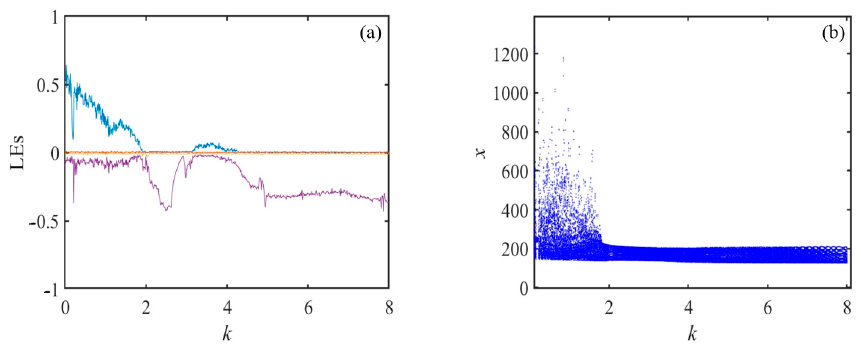
Figure 5. ( a ) Lyapunov exponent spectrum; ( b ) bifurcation diagram. Table 3. Corresponding state and LEs with the initial conditions (1, 1, 1, 1, 1), the parameters a = 10, b = 2, c = 10, d =31, e = 10, g = 1.15 and the different parameter k .